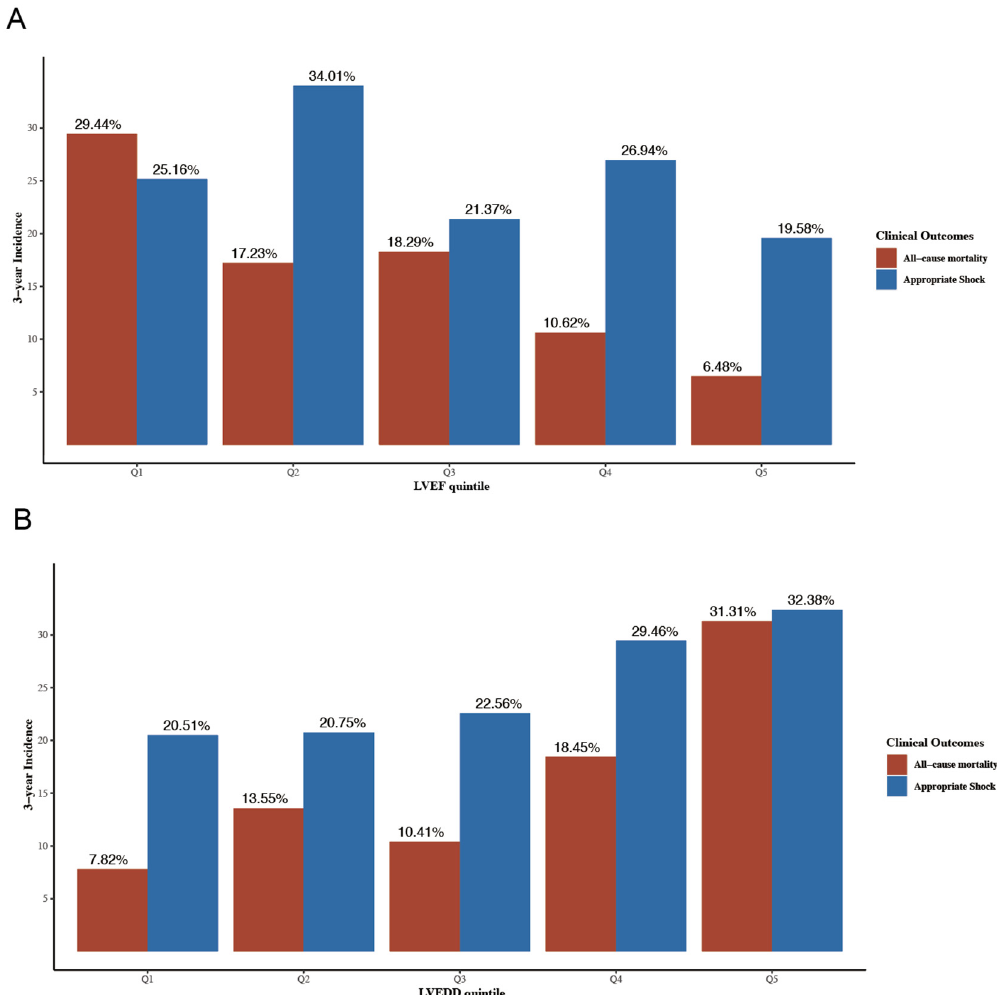
Figure 2. 3-year cumulative incidence of all-cause mortality and appropriate shock according to LVEF quintiles ( A ) and LVEDD quintiles ( B ). LVEDD, left ventricular end-diastolic diameter; LVEF, left ventricular ejection fraction.